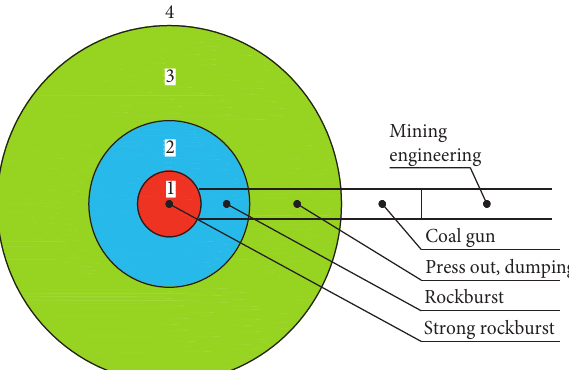
Figure 1: Model of the relationship between the rockburst and the coal-rock dynamic system: 1, dynamic nuclear zone; 2, damage zone; 3, injury zone; 4, influence